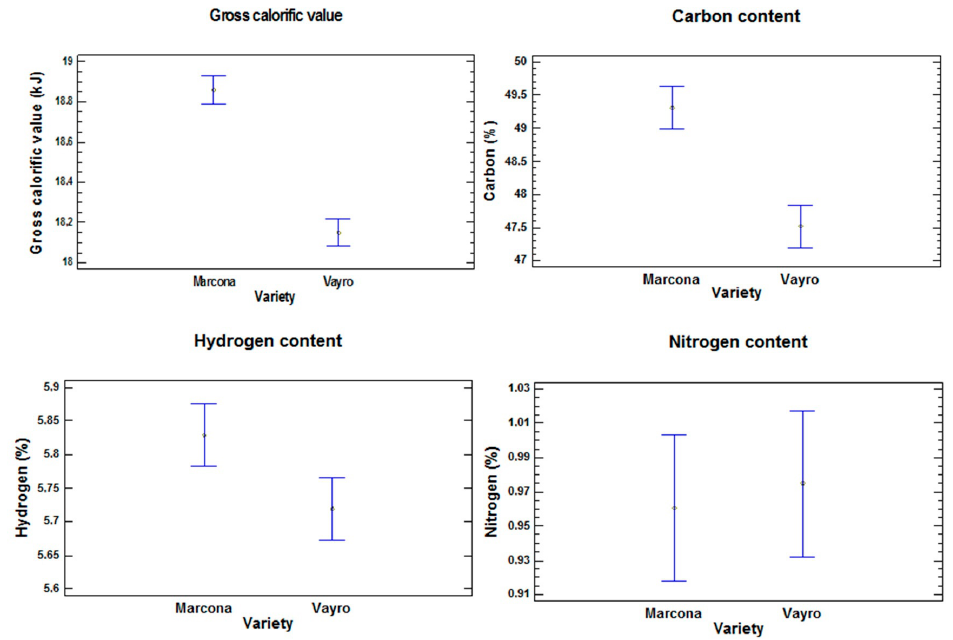
Figure 1. LSD intervals at 90% confidence level in the influence of the variety factor in residual biomass characteristics. ( n = 108).